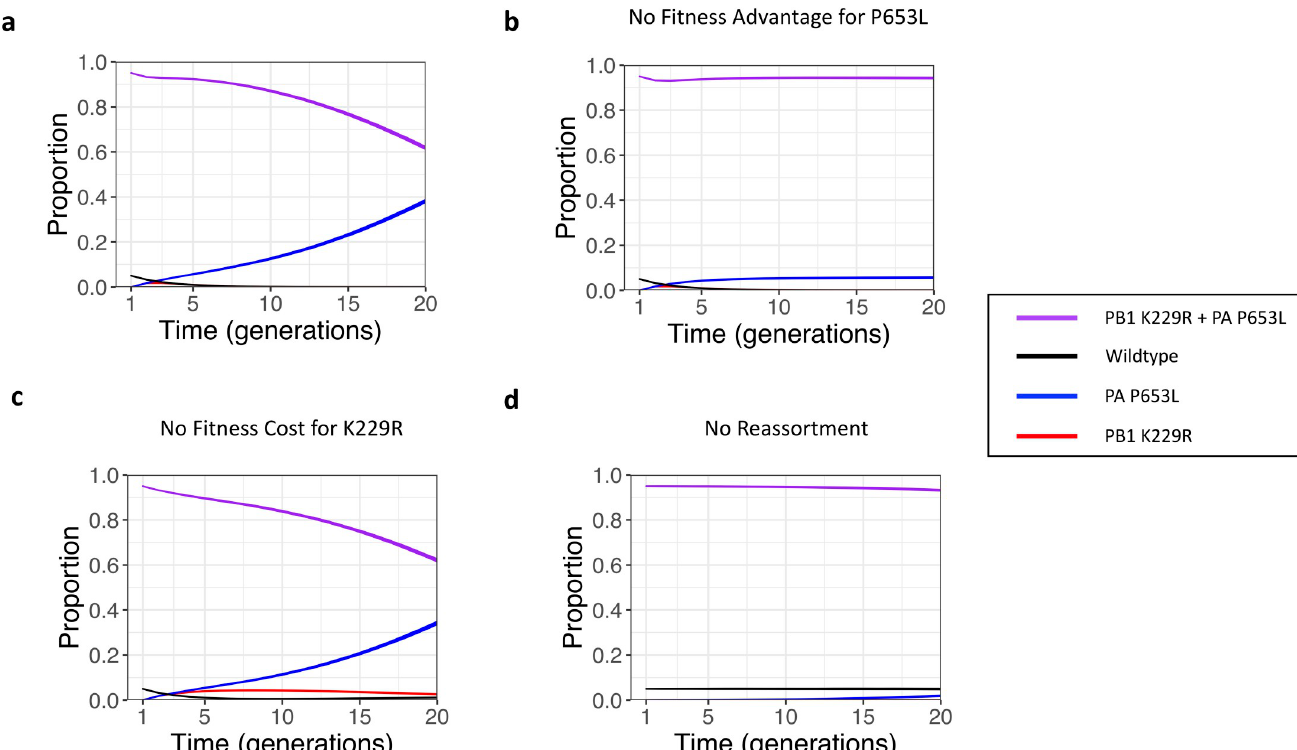
Fig 3. A) The proportion of each virus genotype are shown over 20 rounds of replication for a model with reassortment and mutation. The starting proportions are 5% Wild type and 95% K229R + P653L. Strain fitness for Wild type, K229R, P653L and K229R + P653L were set at 1, 0.01, 1.25 and 1 respectively. 10^6 viruses are modelled with 10^6 cells with a mutation rate, μ = 2 × 10 − 4 . B) As A but the strain fitness for Wild type, K229R, P653L and K229R + P653L were set at 1, 0.01, 1 and 1 respectively. C) As A but the strain fitness for Wild type, K229R, P653L and K229R + P653L were set at 1, 1, 1.25 and 1 respectively. D) As A but there was